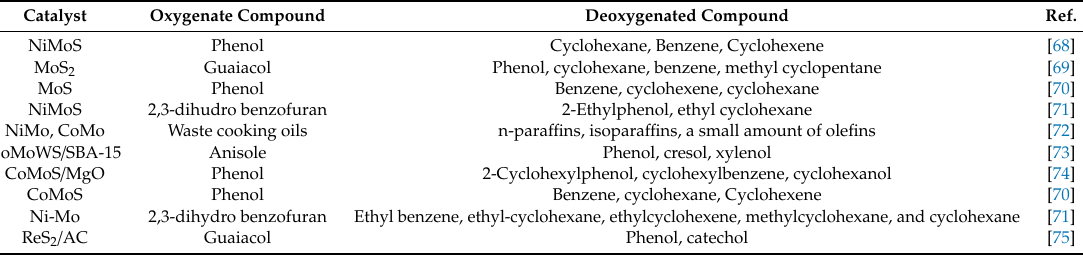
Figure 7. The reaction mechanism for the HDO of 4-methyl phenol over MoS 2 . Reprinted from reference [67]. Table 6. HDO of different compounds over sulphied catalyst.